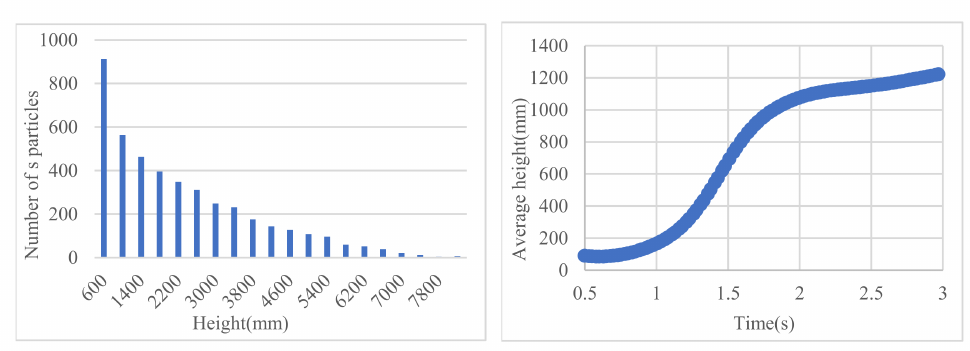
Figure 12. The number of suspended particles at 3 s and the average height of particles in 3